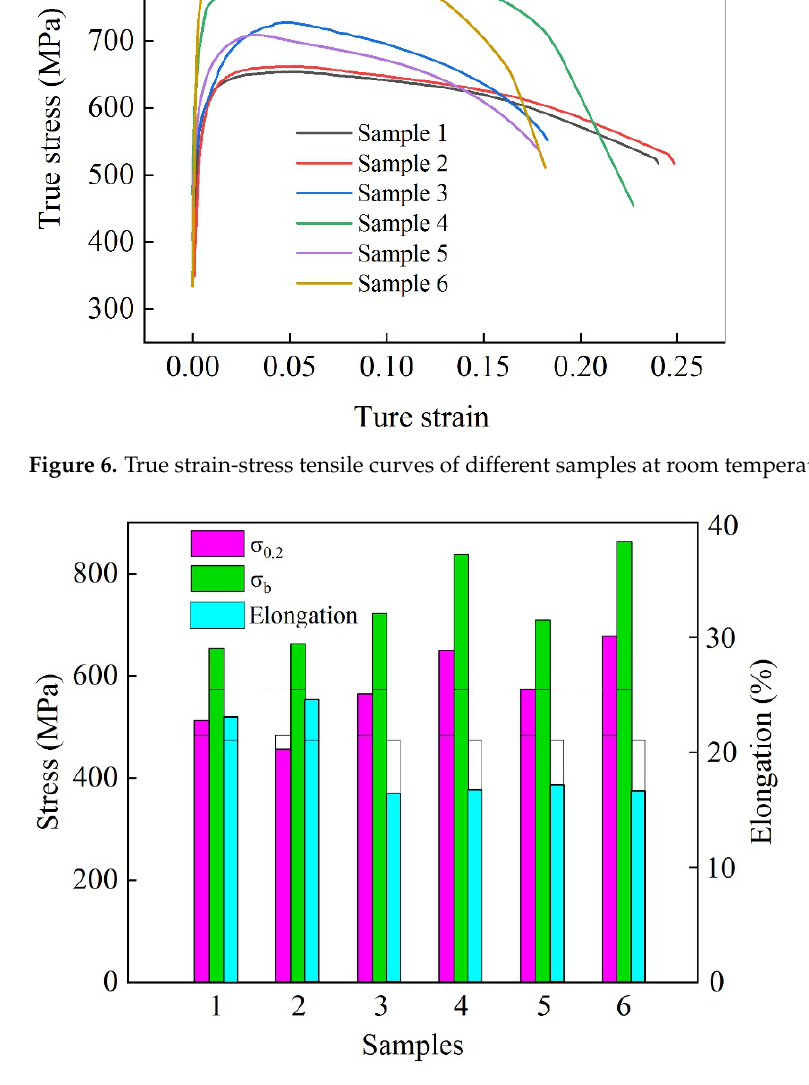
Figure 7. Relevant tensile property data of different samples.